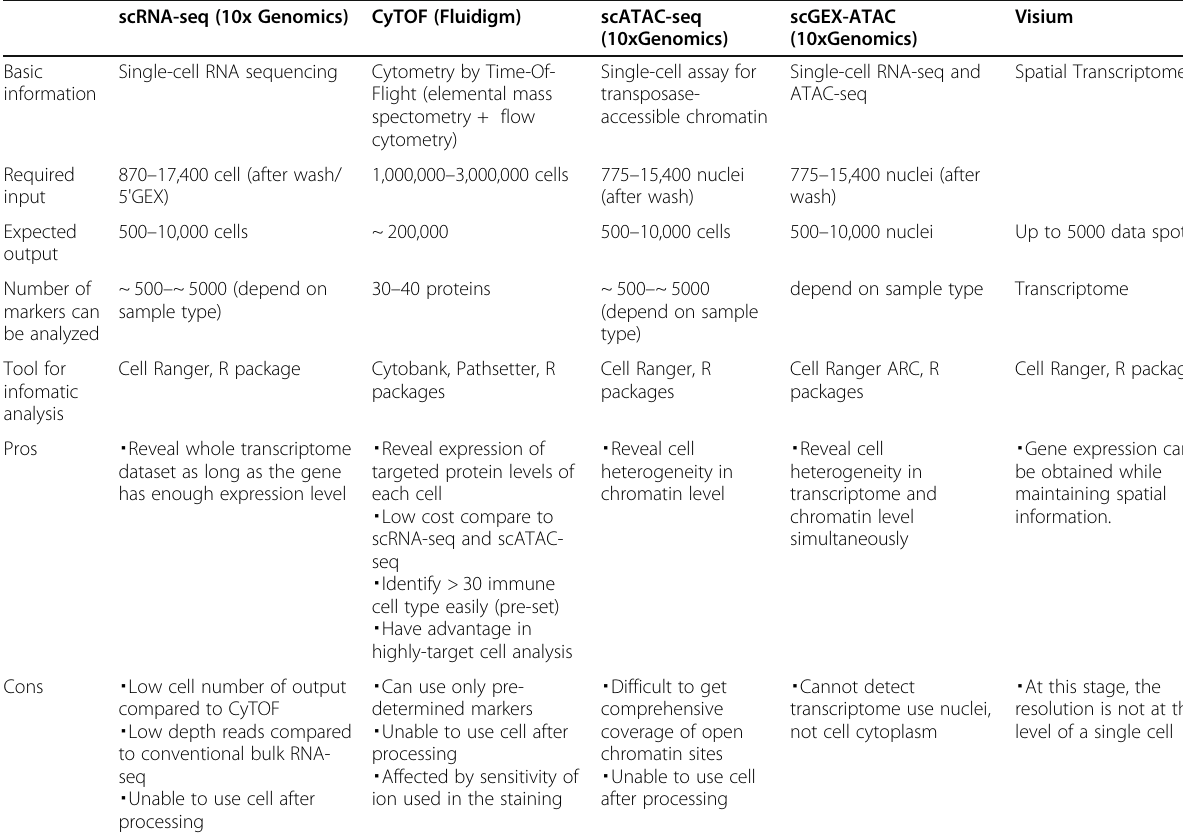
Table 1 Comparison of instrument shown in this